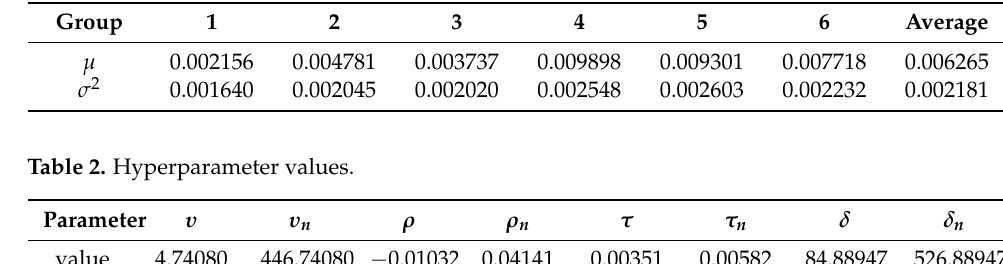
Table 1. Mean and variance of the residuals for the 6 sets of training data.